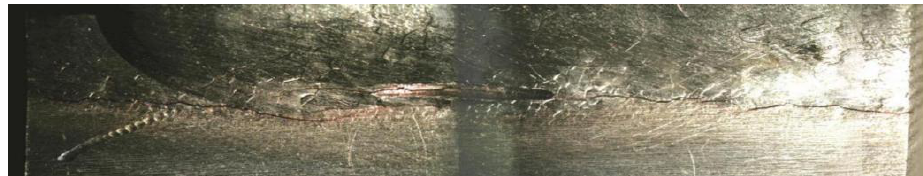
Figure 12. The macroscopic photograph of the crack along the lower edge.